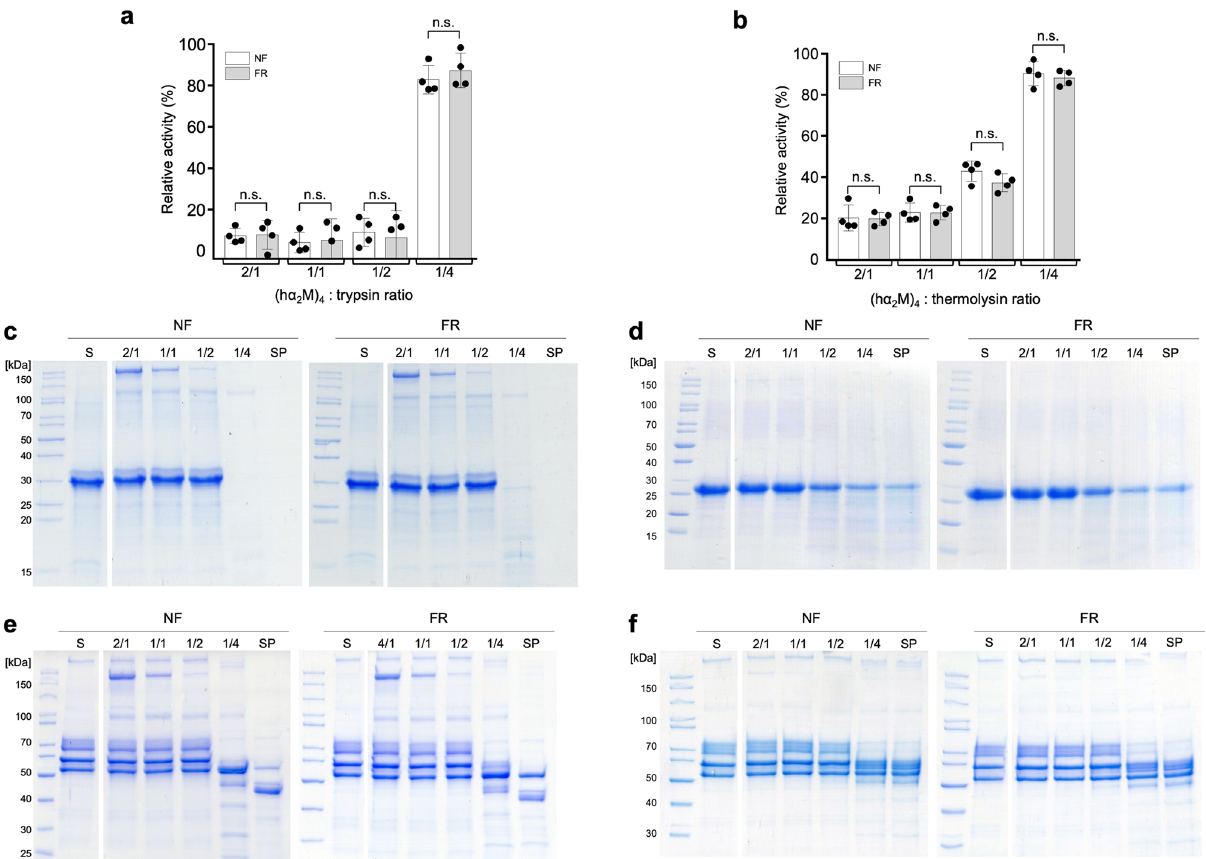
Figure 2. Inhibitory activity in vitro of hα 2 M from non-frozen fresh plasma (NF) or frozen fresh plasma (FR). Inhibition of ( a ) trypsin and ( b ) thermolysin activity against the fluorescent BODIPY FL-casein substrate. Percentages of remaining activity are represented as means ± SD (n = 3). Statistical significance was determined using a two-sided Student’s t-test (n.s., p > 0,1). ( c – f ) SDS-PAGE inhibition assay at different tetrameric hα 2 M:peptidase ratios but constant peptidase concentrations, showing the inhibition of trypsin activity against (c) α-casein and (e) fibrinogen, and the inhibition of thermolysin activity against (d) α-casein and (f) fibrinogen, for which only the Aα chain is cleaved. Lanes S and SP correspond to the substrate alone and the substrate incubated with and processed by the peptidase,